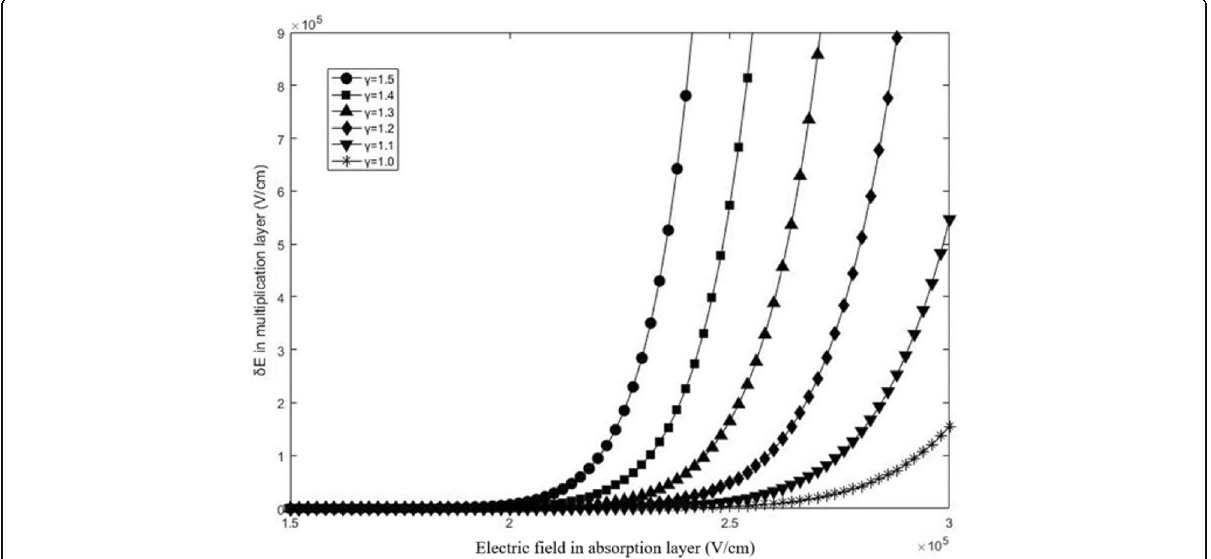
Fig. 6 The δ E for different fields in the absorption layer with different γ . The values of γ is 1.0 (black star), 1.1 (black down-pointing triangle), 1.2 (black diamond), 1.3 (black triangle), 1.4 (black square), 1.5(black circle). Presents the calculated results of δ E by Formula 16. When the field of absorption exceeds 19 kV/cm, δ E gradually increases. It also can be found that δ E adapts the same order of magnitude for the avalanche field in the multiplication. Thus, the tunneling effect has an influence on the avalanche field with the tunneling